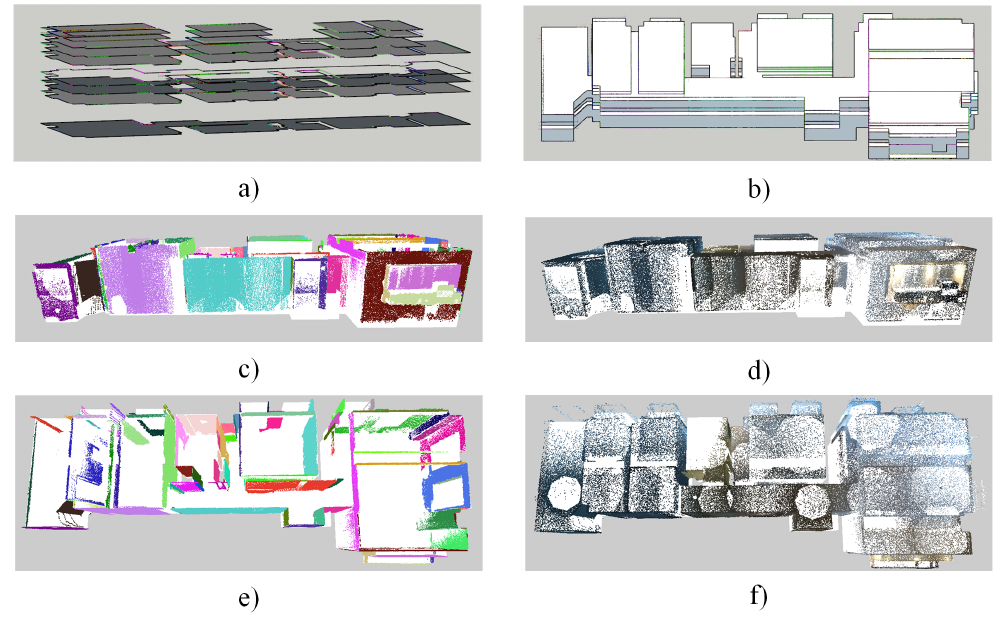
Figure 19. The process and results of building reconstruction: ( a ) The result of contour extraction (in layers), ( b ) the result of initial contour assembly, ( c , d ) the front view of building reconstruction overlapping with point clouds, and ( e , f ) the top view of reconstruction results. The colored point clouds in ( c , e ) represent the labels of segmentation, and the original point clouds are depicted in ( d , f ).